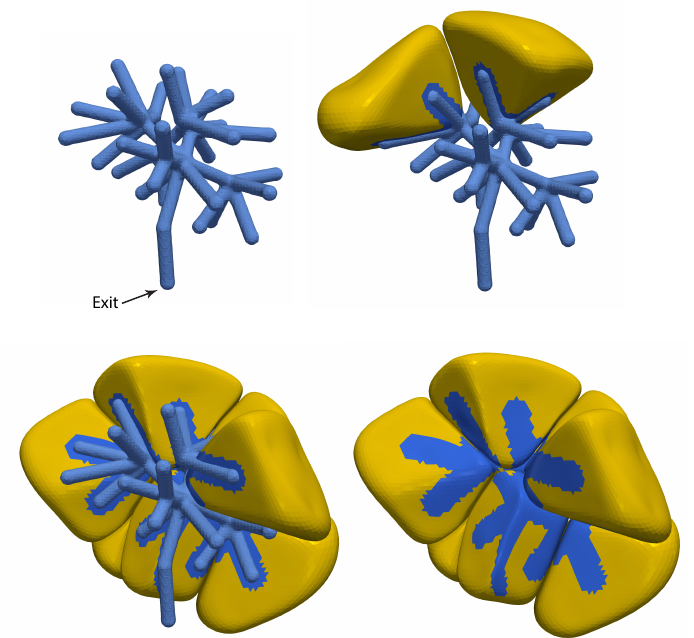
Figure 7. Three-dimensional reconstruction of an apical lumen “tree” associated with a 14-cell acinus. The panels show four different views of the same acinus. The ( top left panel ) shows the apical lumen reconstruction, with the exit (to the duct) labelled. The ( top right panel ) shows the same lumen, but now with two acinar cells included, to show how the fingers of the lumen wrap around each cell. Additional cells are show in the ( bottom two panels ), with the lumen tree removed in the ( bottom right panel ), fully exposing a view of the surface